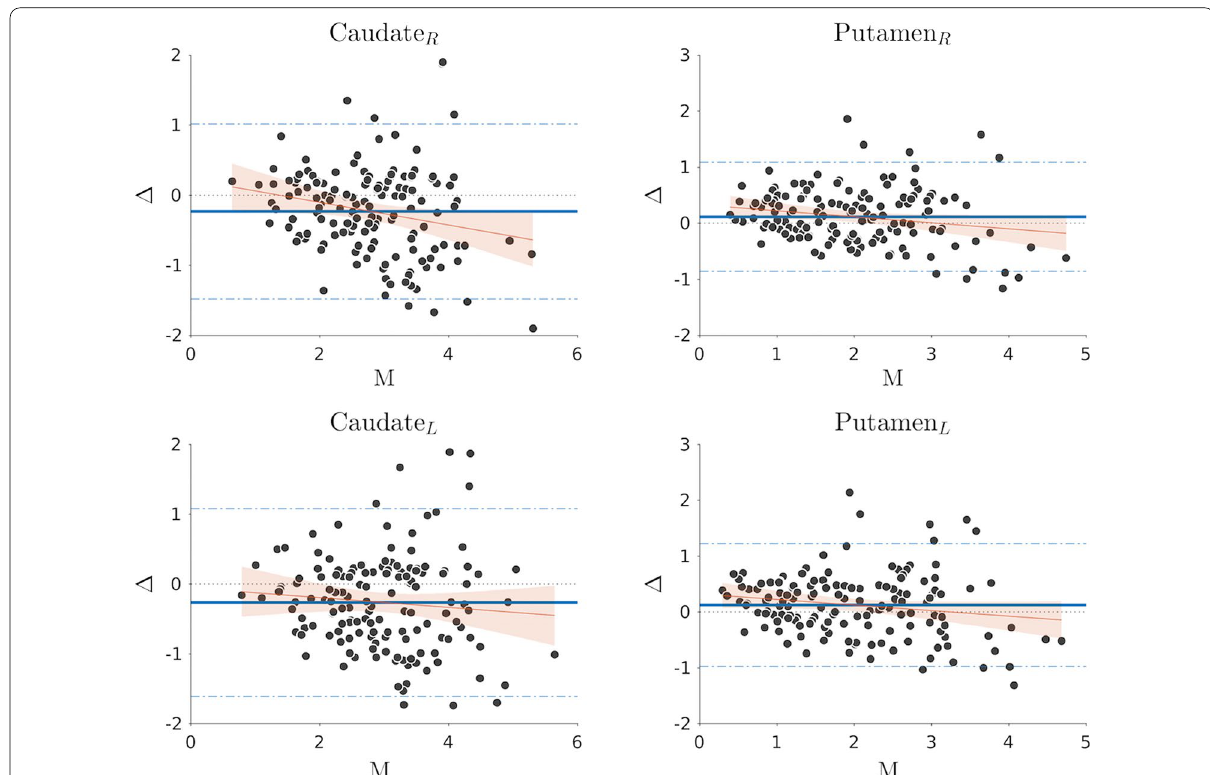
Fig. 4 Bland–Altman plot showing the mean bias between Datquant ® and BasGanV2 SBR values for each of the four basal ganglia nuclei, with the 95% confidence limits (CL). Proportional bias regression line and its CLs. Numerical results for all variables are reported in Table 2